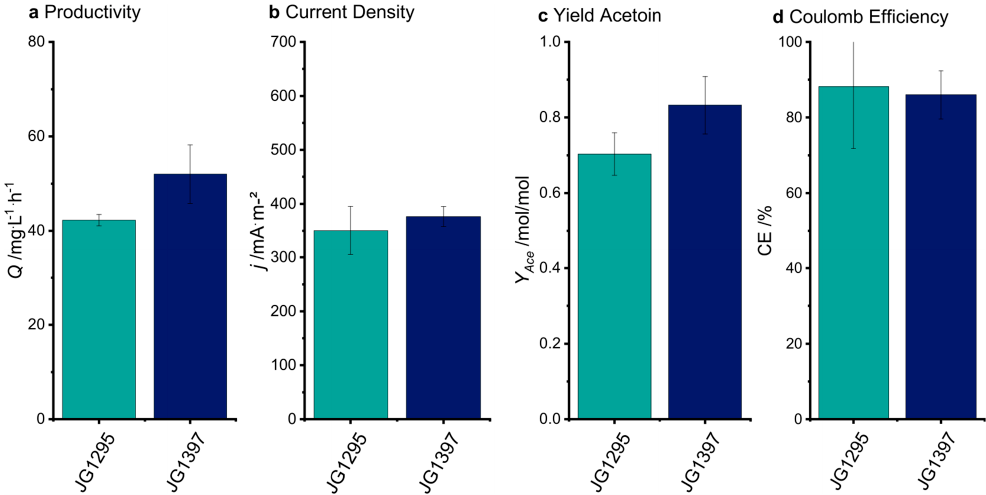
Figure 6. Evaluation of the electro-fermentation experiments for JG1295 and JG1397. All parameters are insignificant between the two strains. ( a ) Productivity (Q), ( b ) Average Current Density (j), ( c ) Yield Acetoin (Y Ace ), ( d ) Coulomb Efficiency (CE).